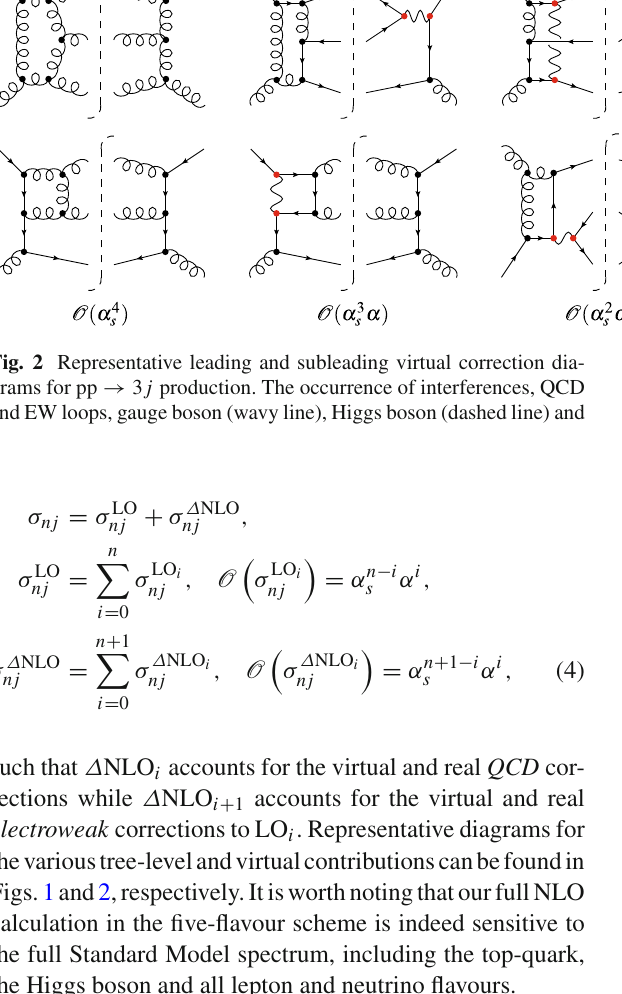
Fig. 1 Representative leading and subleading tree-level diagrams for pp → 3 j production. The occurrence of QCD and electroweak interfer- ences, internal electroweak bosons and external photons (wavy lines)